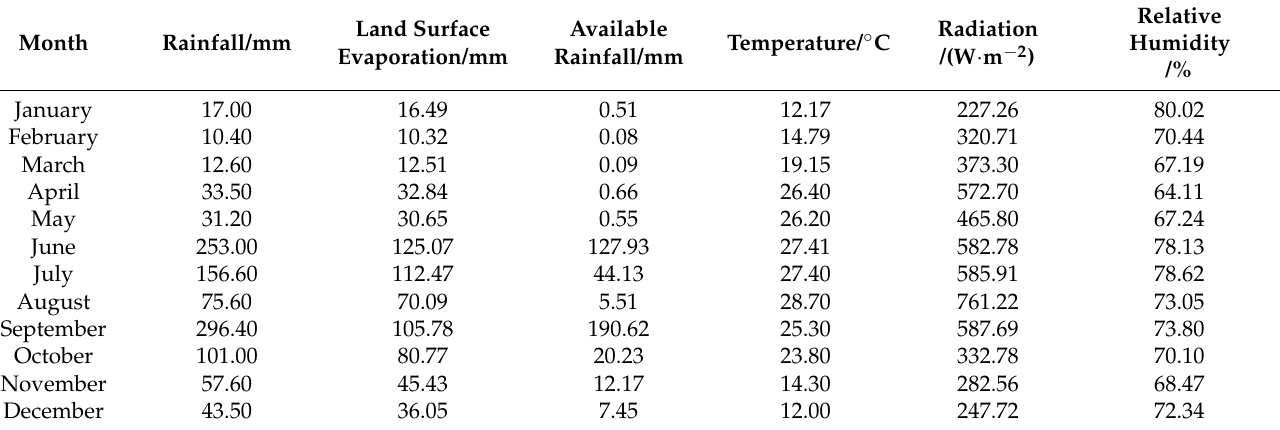
Table 1. Meteorological data statistics (2019 data)